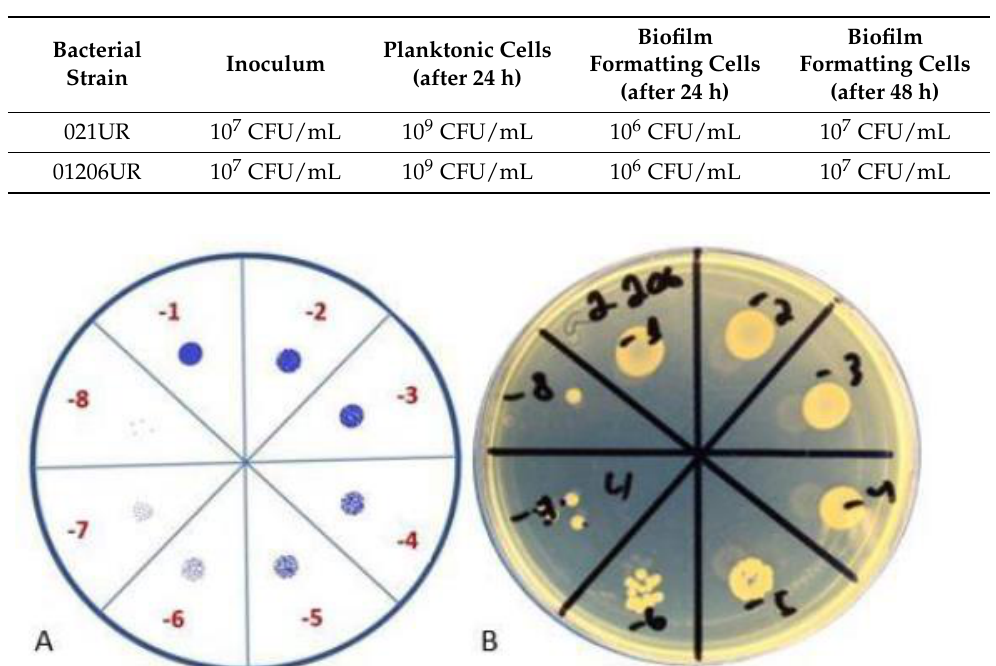
Table 3. Results of colony-forming unit spot test.